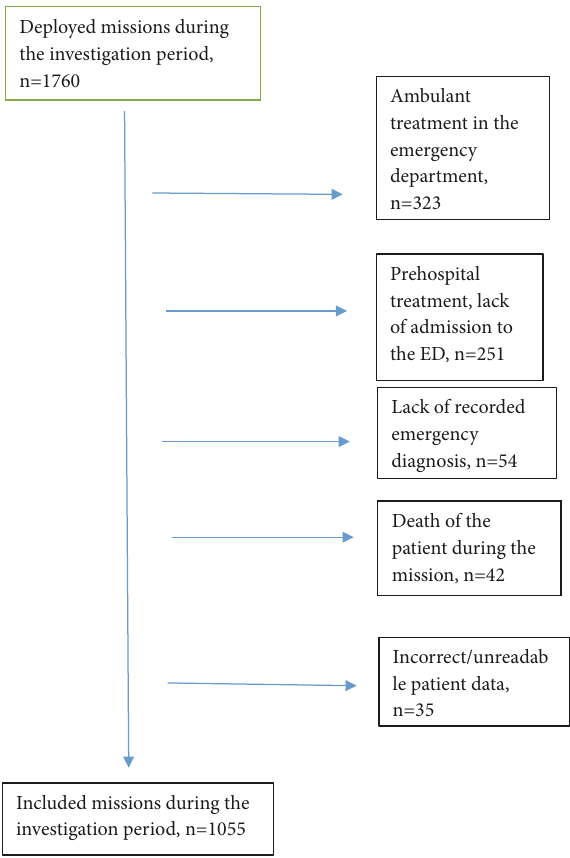
Figure 1: Inclusion